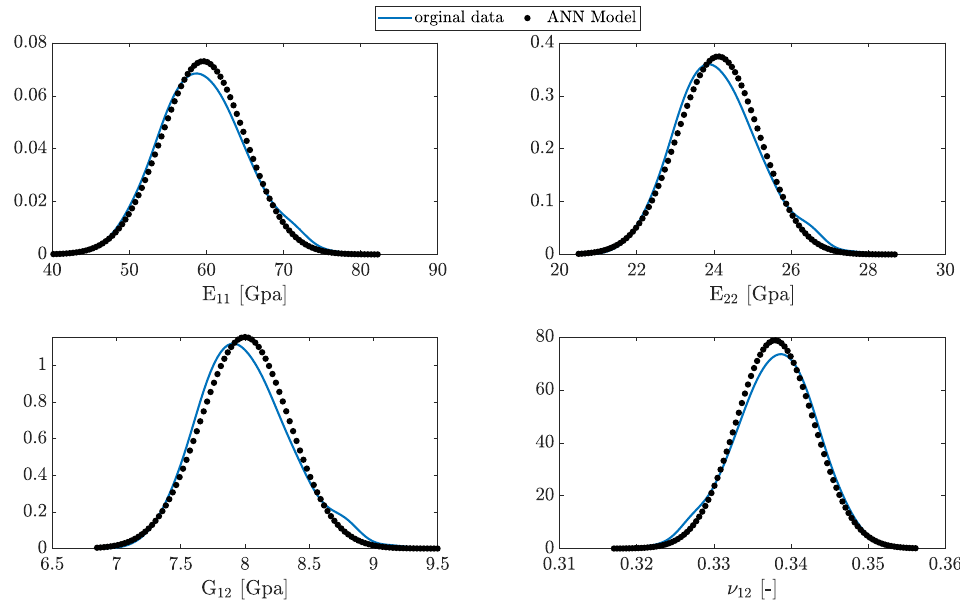
Figure 12. The predicted PDF of the new data set from the model compared to original